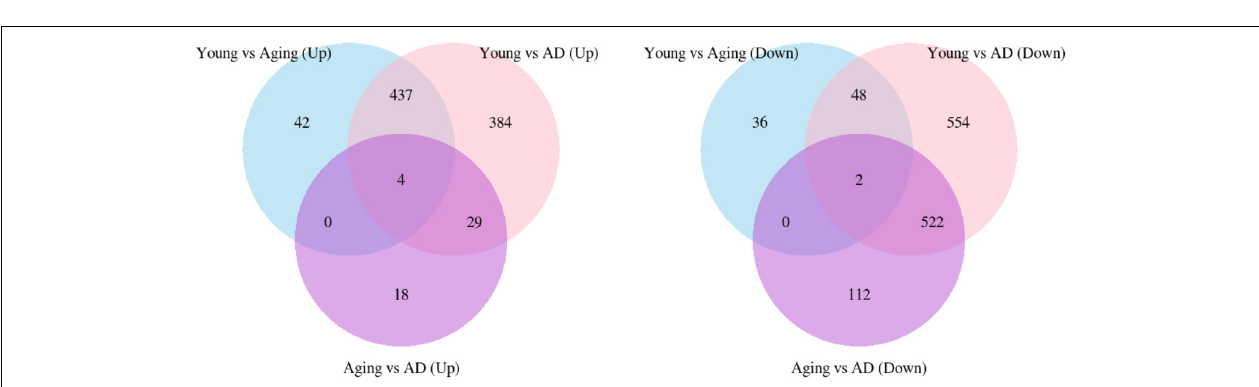
FIGURE 4 | The overlap of upregulated and downregulated DEGs between young vs. aging, young vs. AD and aging vs. AD.